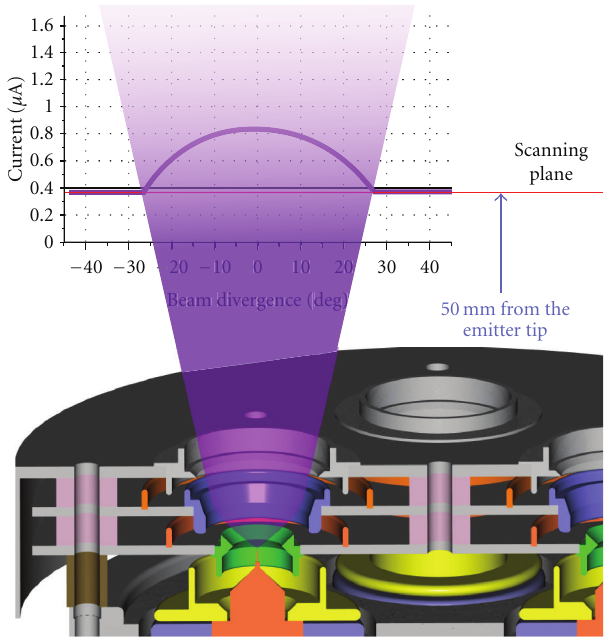
Figure 5: Focusing electrode.